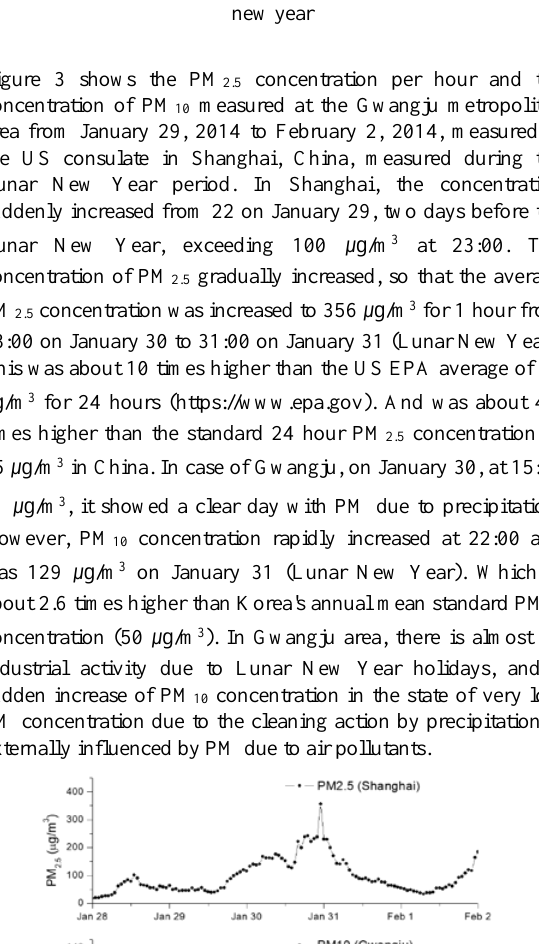
MODIS L2 collection 6 of Terra satellites was averaged 10 km × 10 km lattice averaged 10 km pixels from 2001 to 2014 to see the change of AOD caused by repeated fireworks every year. 2 (d), 1 day before (Fig. 2 (b)) and 1 day after Lunar New Year